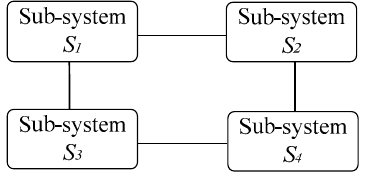
Figure 3. Communication topology of the IEEE 14-bus sub-systems.